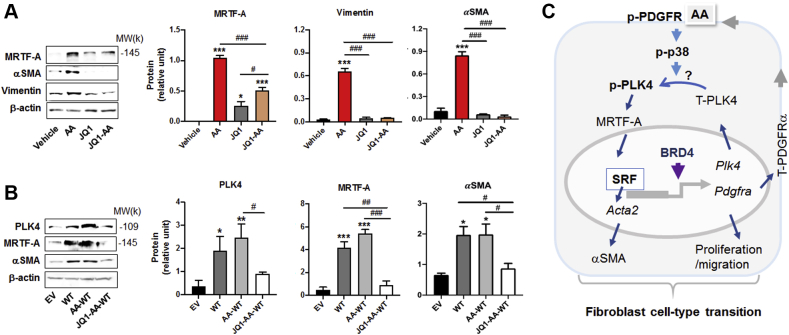
BET Inhibition Blocks MRTF-A and αSMA Expression in the Background of PLK4 Overexpression(A) Effect of BET inhibition without PLK4 overexpression. Rat adventitial fibroblast cells were cultured and starved as described in Figure 1. Cells were pretreated with vehicle or JQ1 (1 μmol/l) overnight and then stimulated with AA (60 ng/ml, 24 h) before cell harvest. (B) Effect of BET inhibition with PLK4 overexpression. Fibroblast cells (C3H cell line) transduced with lentivirus to express the empty vector control (EV) or PLK4 wild type (WT) were selected with puromycin, starved overnight, pretreated with vehicle or JQ1 (1 μmol/l) overnight, and then stimulated with AA (60 ng/ml, 24 h) before cell harvest. PLK4 was detected by Western blotting against the PLK4 protein. Quantification: mean ± SEM, n = 3 experiments, 1-way ANOVA/Bonferroni test: #p < 0.05; ##p < 0.01; ###p < 0.001. ∗p < 0.05; ∗∗p < 0.01; ∗∗∗p < 0.001 compared with the vehicle or EV control without AA (the first bar in each plot). (C) Schematic model for regulations up- down-stream PLK4. In an acute phase (within 10 min), AA as extracellular signal initiates activation of the PDGFRα → P38 → PLK4 pathway. PLK4 phosphorylation elevates MRTF-A protein, which in turn activates SRF and αSMA expression. At the transcription level, BRD4 as an epigenetic determinant promotes the transcription of PLK4, as well as PDGFRα, which further enhances PLK4 phosphorylation. The “?” mark indicates that our current data cannot distinguish whether P38 is indirectly or directly responsible for PLK4 phosphorylation. Abbreviations as in Figures 1, 2, 4, 12, and 13.